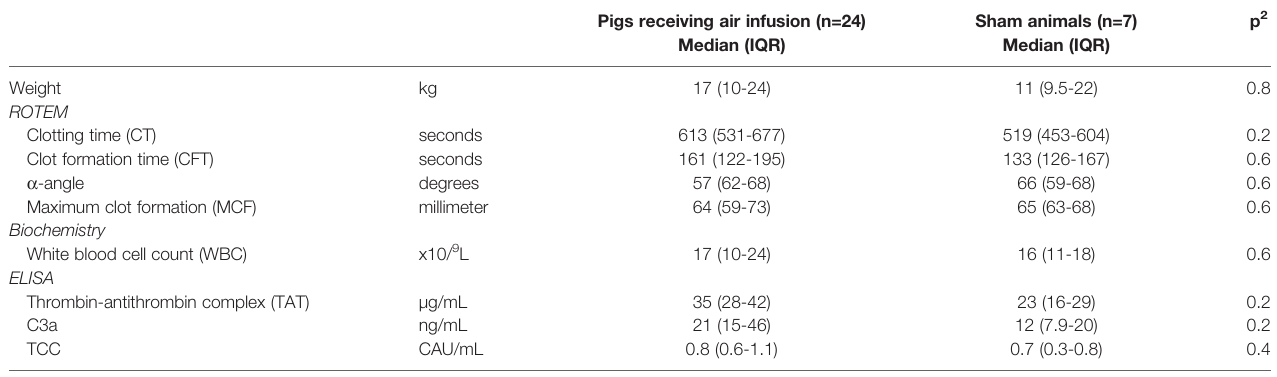
TABLE 1 | Characteristics of pigs included in the study at baseline 1 .